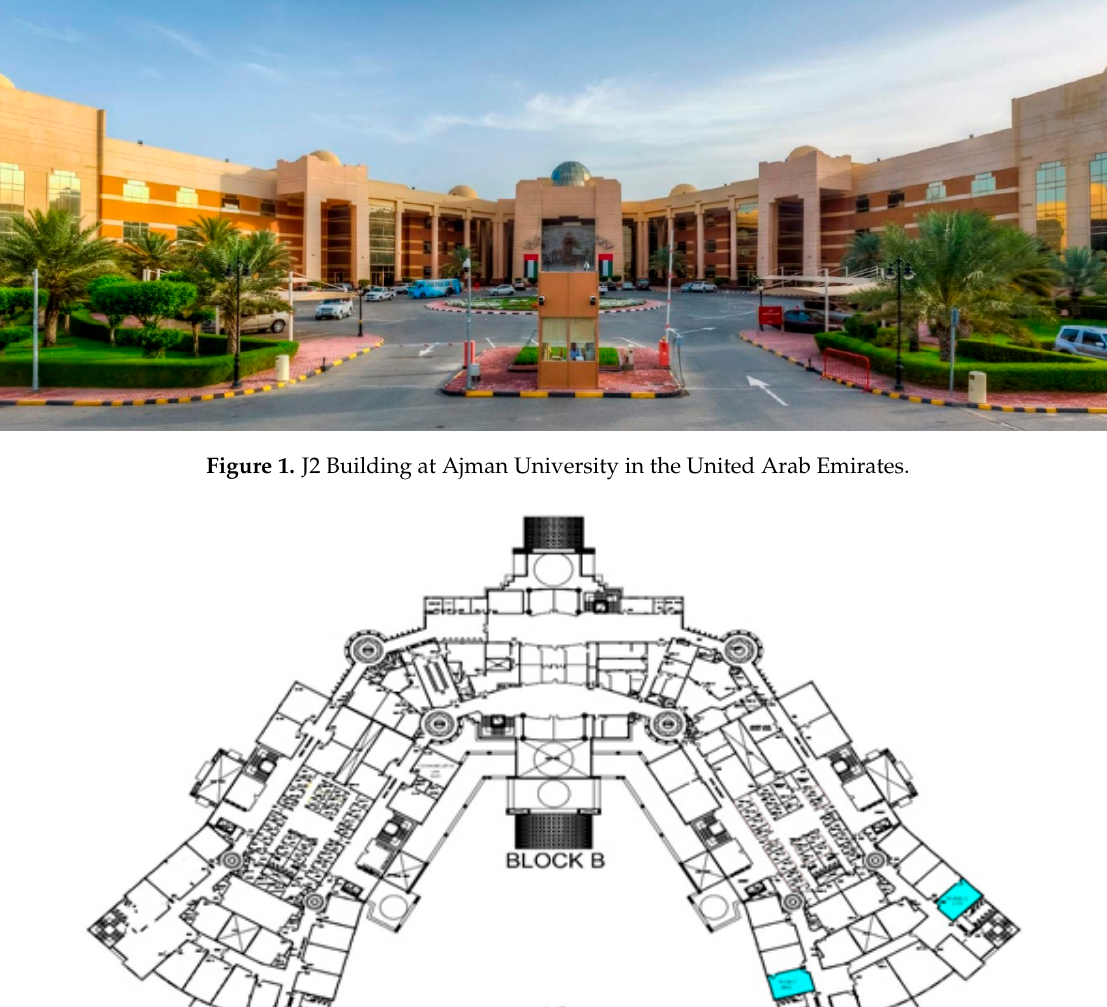
3:1 The leaf area of the target plant was calculated using an AutoCAD program after scanning the average leaf, and it was 300 cm 2 /pot. A total of 48 pots of areca palms (pot size: 15 cm × 21 cm) were placed in a line next to the windows in each classroom, and the plant density was about 14.68% of the floor area. Based on the Dubai Municipality’s reg- ulation regarding indoor air quality (IAQ), in 8 h of continuous monitoring prior to occu- pancy [66,67], 8 types of indoor pollutants (CO 2 , CO, O 3 , VOCs, HCHO, SO 2 , NH 3 , and NO 2 ) were selected, but we focused on the CO 2 concentrations in the classroom setting.